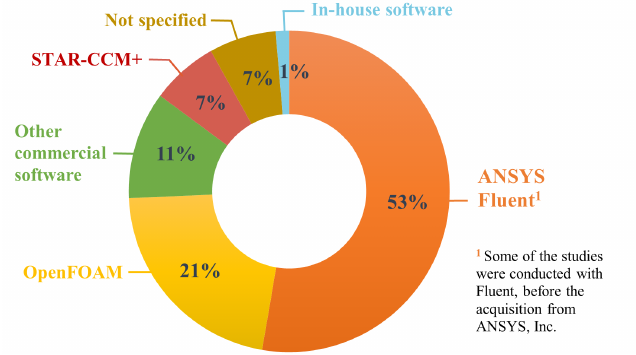
Figure 5. Software usage in publications.